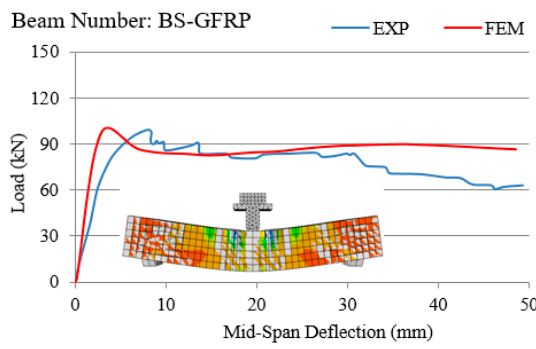
Figure 12. Load vs. mid-span deflection for BS-GFRP.